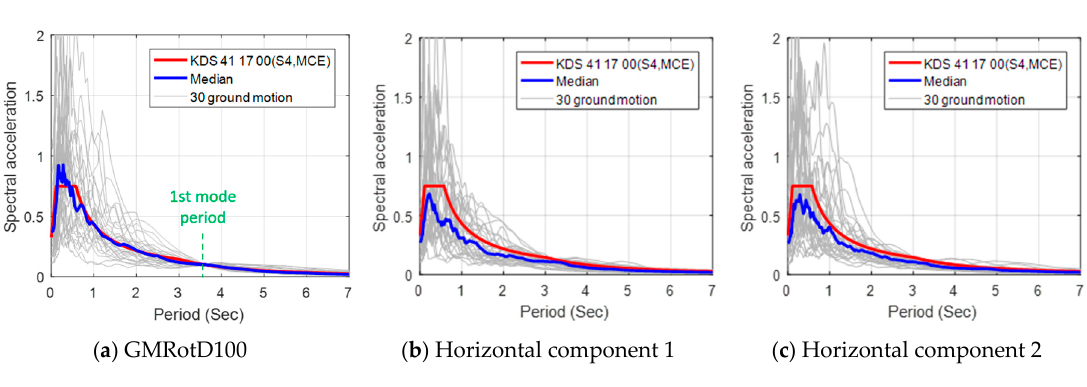
Figure 9. Target and scaled response spectra for Model B.